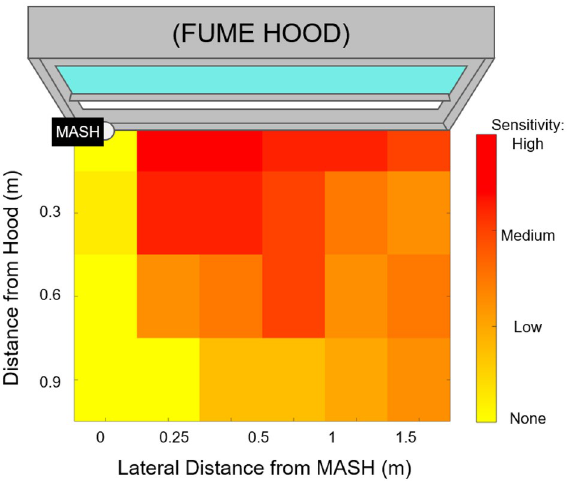
Figure 3. PIR motion sensor characterization. 1.2 m (four feet) above the ground and in front of the fume hood, PIR motion sensors produced repeatable results and are suitable for use in this application. Qualitatively, “high” sensitivity indicates that only a small movement by a human user can be sensed (a small motion of a finger), while “low” sensitivity indicates that a large movement (waving a hand) is required for the sensor to detect motion. The sensor should be positioned away from common walking routes to avoid false motion detections.